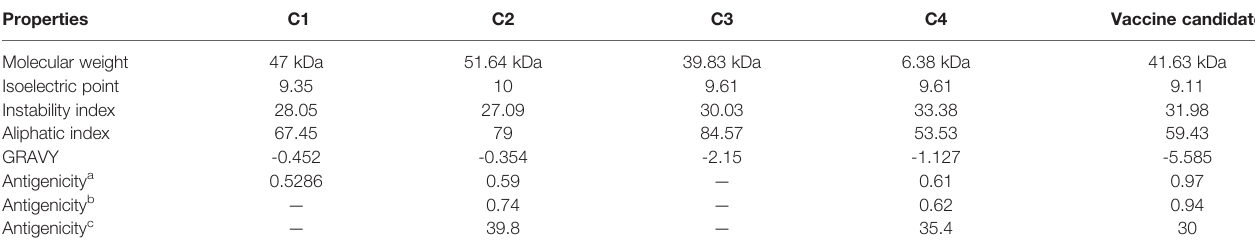
TABLE 4 | Comparison of several physicochemical properties of the positive vaccine controls and C. dif fi cile candidate vaccine. Properties Molecular weight